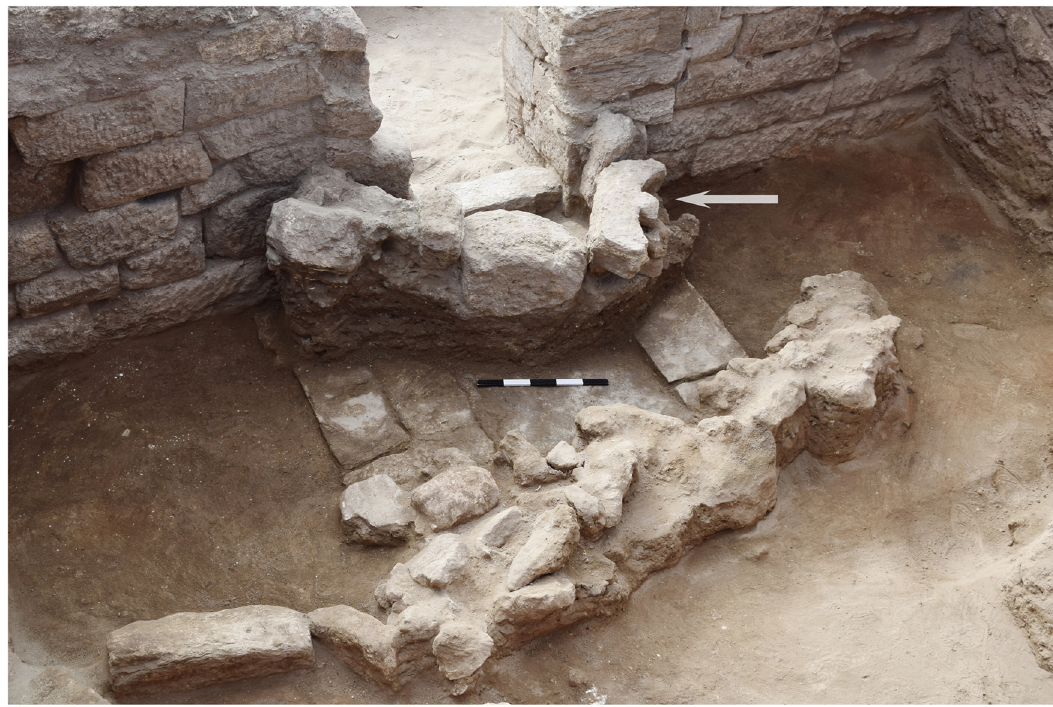
Figure 4: The low wall in front of the northern doorway. The blocked - out capital fragment is marked by an arrow, scalebar measures 50.0 cm ( photography: S. E. Sidebotham ) .